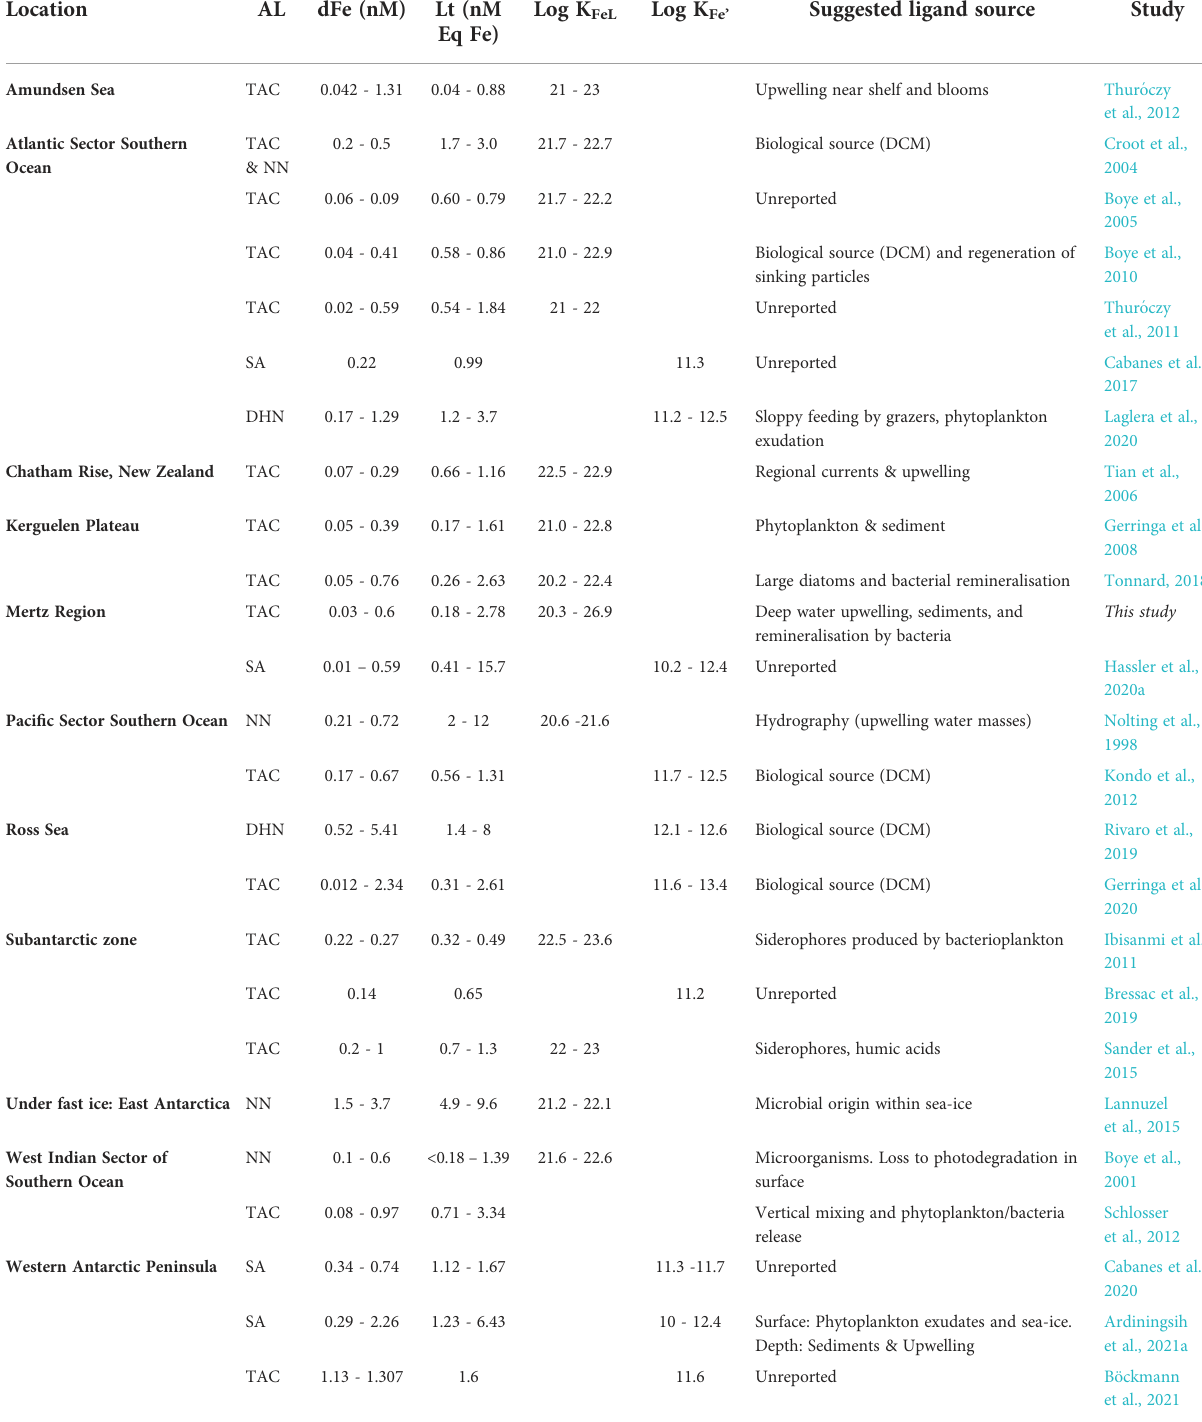
The table is arranged by sampling location and year published. Arti fi cial ligands (AL) used in CLE-CSV analyses include 2-(2-thiazolylazo)- p -cresol (TAC), 1-nitroso-2-napthol (NN), salicylaldoxime (SA) and 2,3-dihydroxynaphtalene